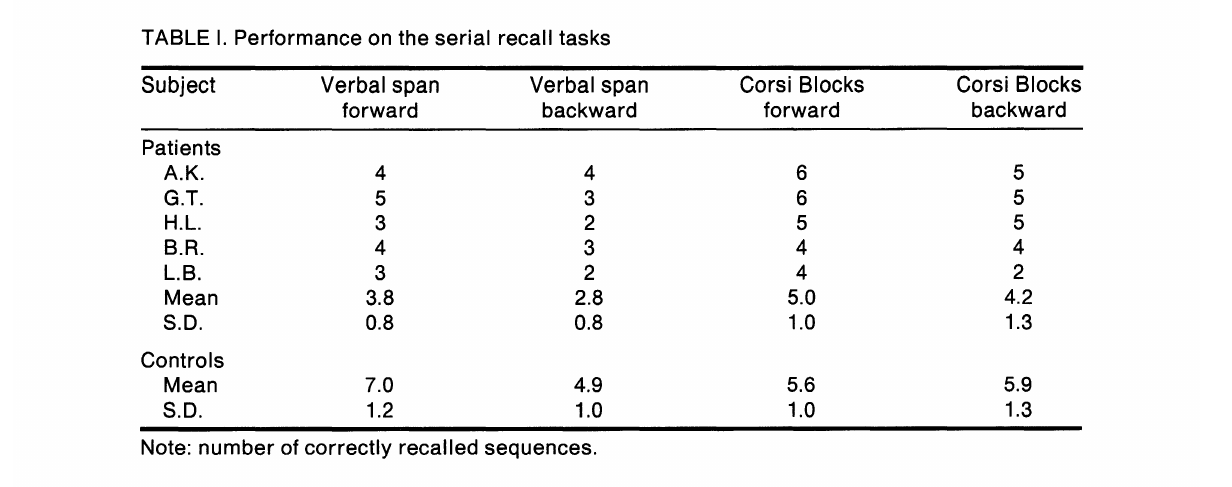
TABLE I. Performance on the serial recall